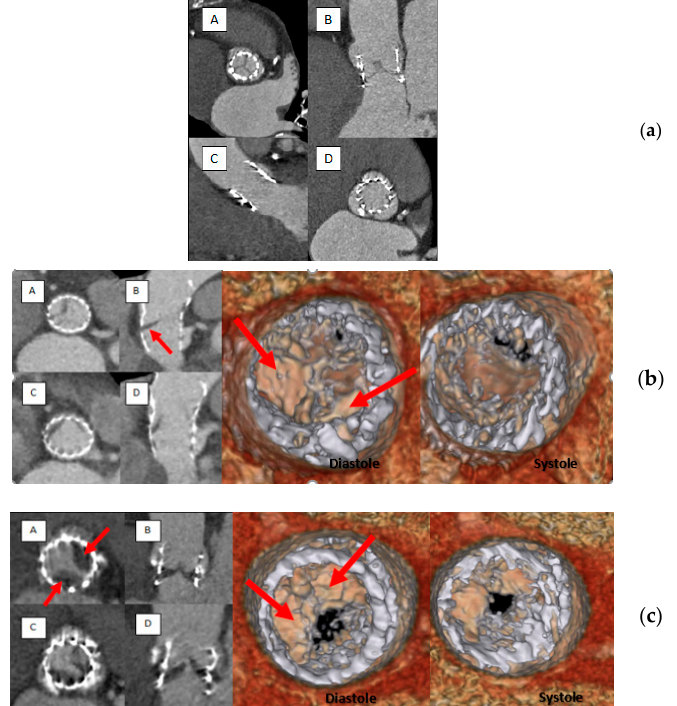
Figure 2. ( a ) MDCT images of normal (without HALT) Edward Sapien prosthesis in diastolic (short axis, A, and long axis, B) and in systolic (long axis, C, and short axis, D) phases. ( b ) MDCT images of HALT + (red arrow) RELM- in diastolic (short axis A, and long B axis) and in systolic (short axis, C, and long axis, D) phases. ( c ) MDCT images of HAM + prosthesis: HALT + (red arrow) and RELM + in diastolic (short axis, A, and long axis, B) and systolic (short axis, C, and long axis, D) phases.